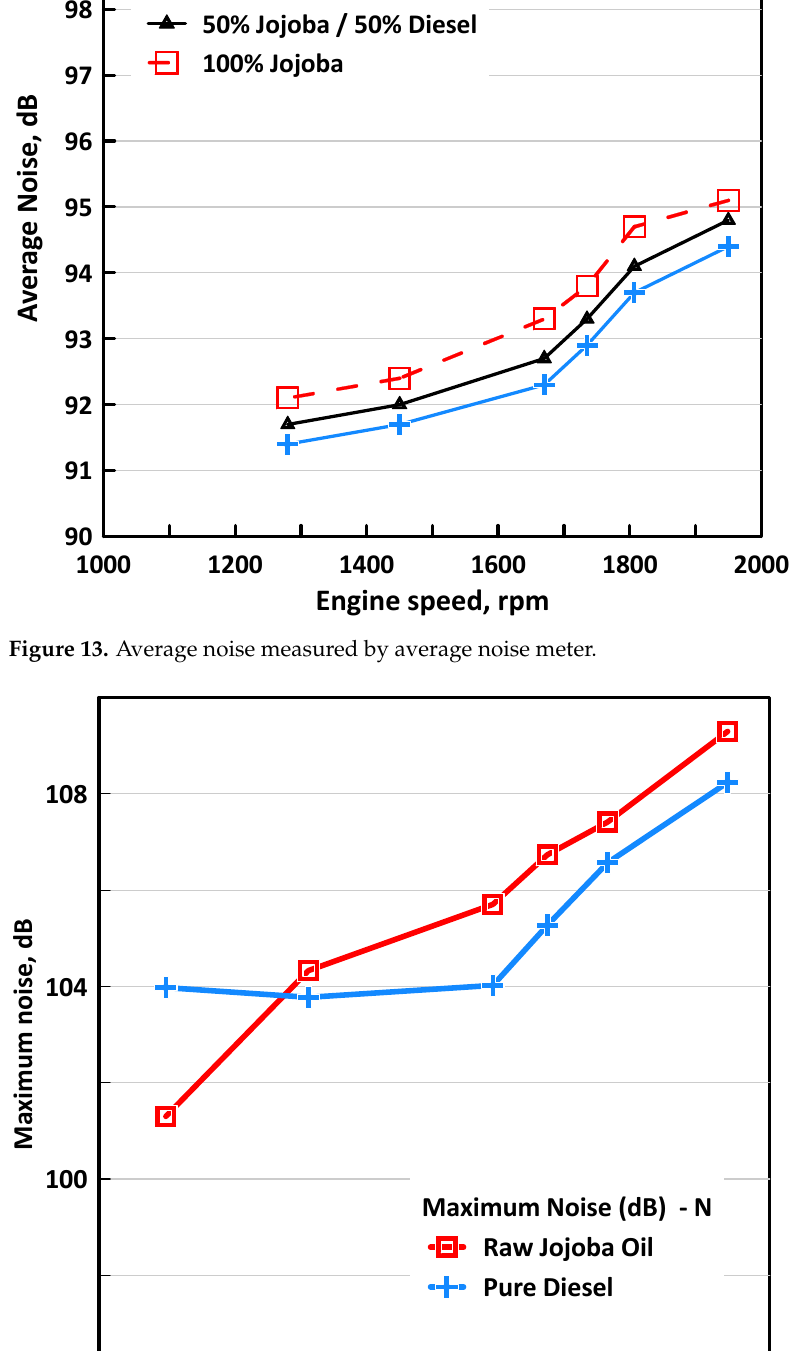
five-hundred cycles collected for repeated engine cycles. The figure illustrates the time-domain data for two engine speeds of 1280 and 1950 rpm. Figure 16 shows the maximum vibration value at each engine speed for the ensemble-averaged cycle for the two fuels. It may be seen that the vibration produced for the Jojoba fuel was less than the vibration measured for diesel fuel case at all engine speeds. This seems to be good news for the Jojoba candidate. For example, at 1800 rpm engine speed, the maximum vibration magnitude for diesel fuel case was about 46.5 g while it was about 37 g for the Jojoba fuel case. These are the maximum vibration value recorded over the engine cycle. As seen in Figure 15, that the vibration signal has different peaks, e.g., one for maximum pressure rise rate associated with combustion process, one for intake valve opening/closure, and another for exhaust valve opening/closure. To explain the low vibration values in case of